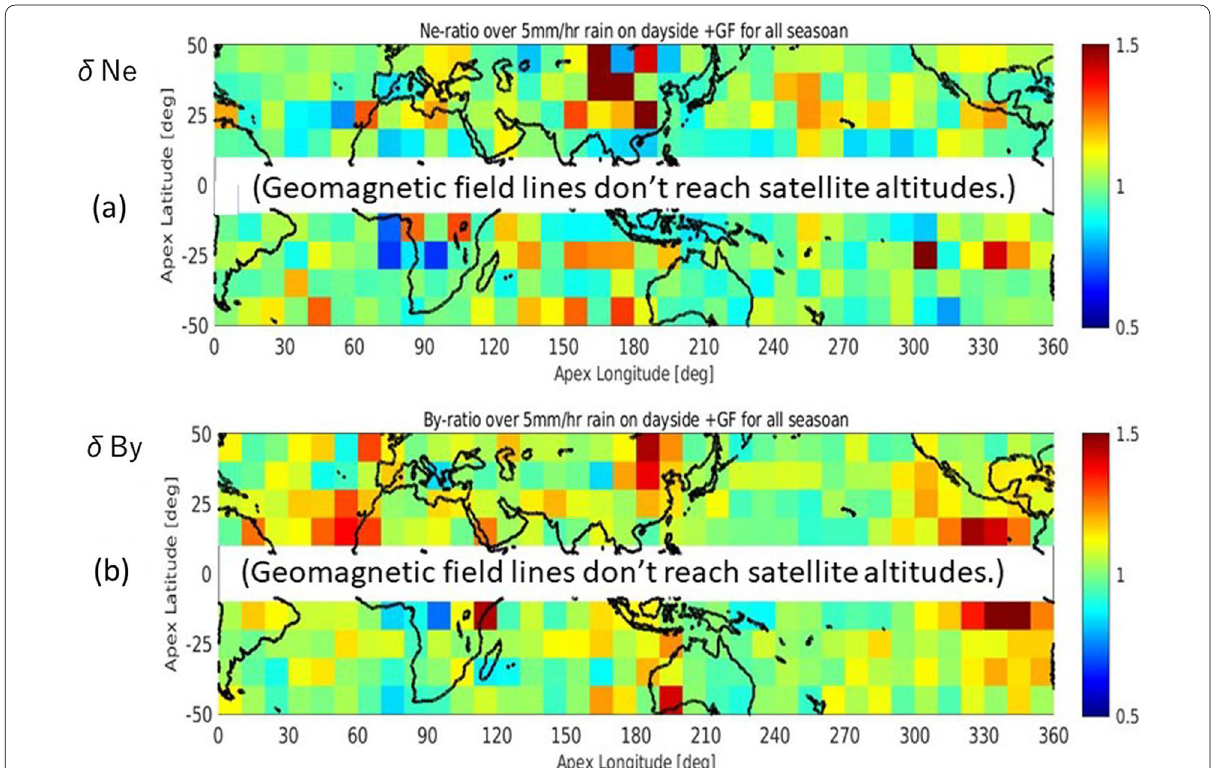
Fig. 8 Same as Fig. 6a and b, but in Apex coordinate system. The blank area within force in this area cannot reach satellite altitudes. The Apex latitudes of the coast-lines are calculated at 120 km altitudes assuming that the magnetic ripples are generated in the ionospheric dynamo